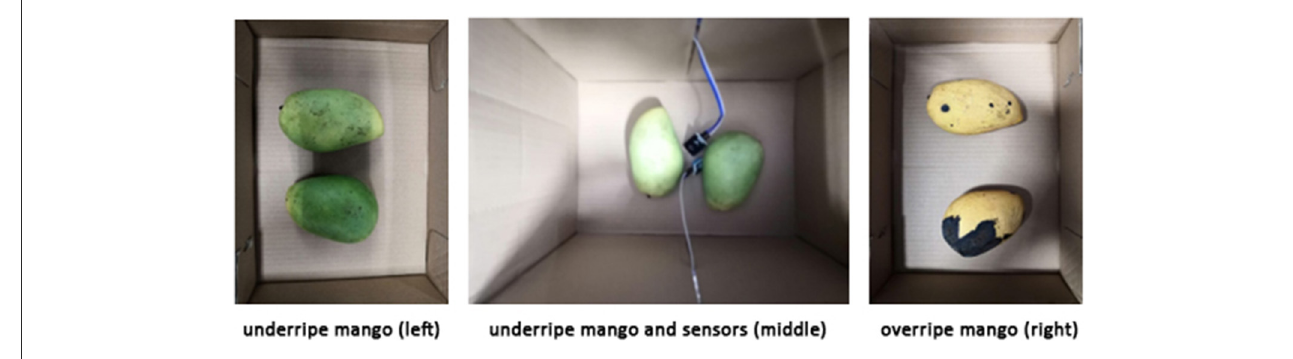
FIGURE2 Underripe mangoes (left) , and overripe mangoes (right)